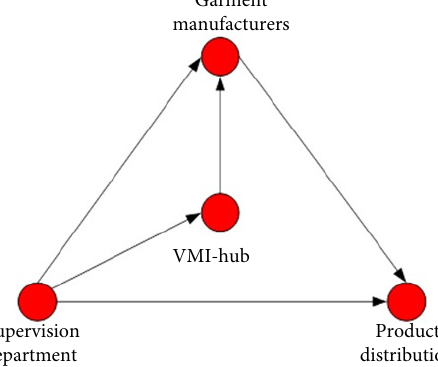
Fig. 2 Relationship among various market roles in